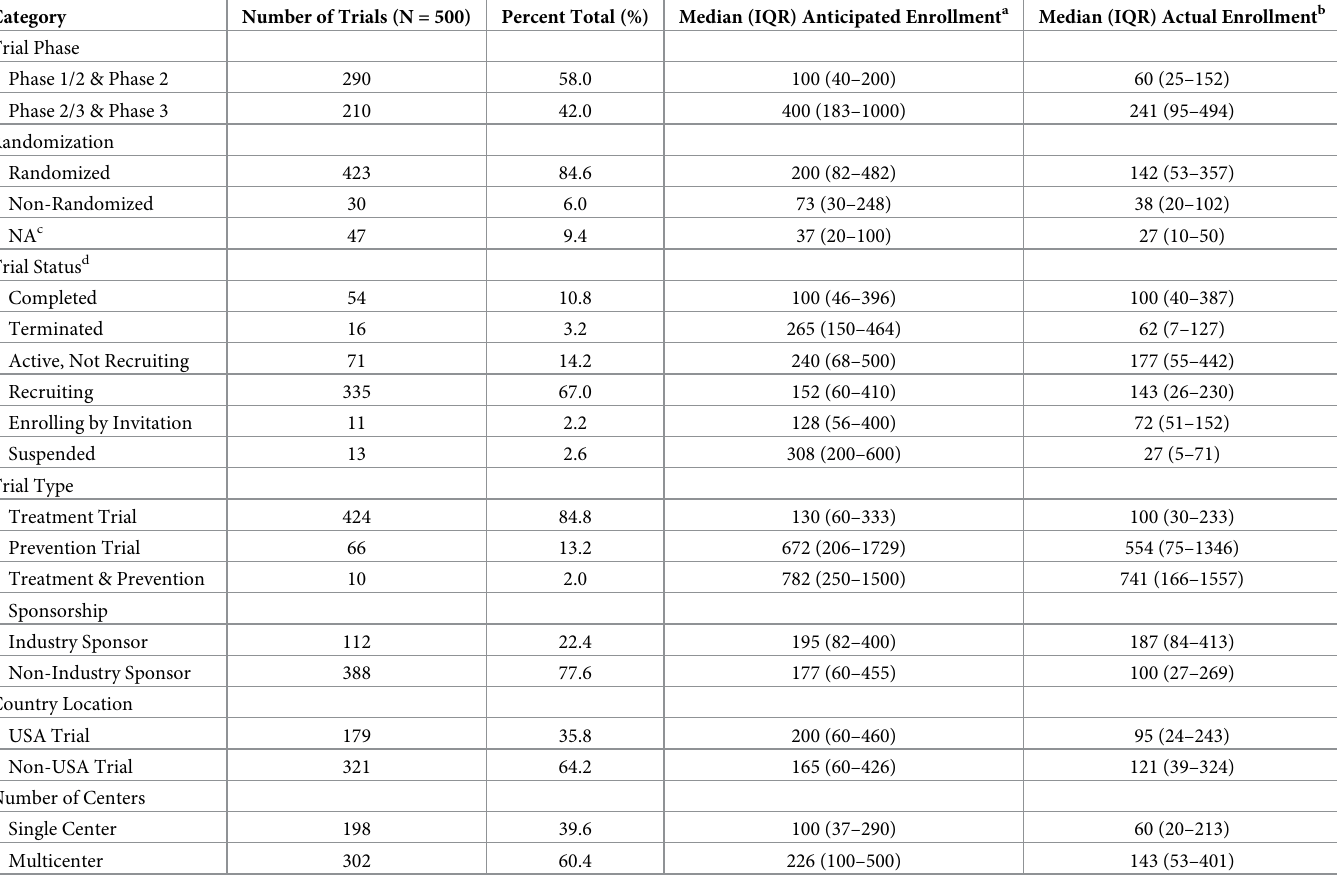
Table 1. Characteristics of trial